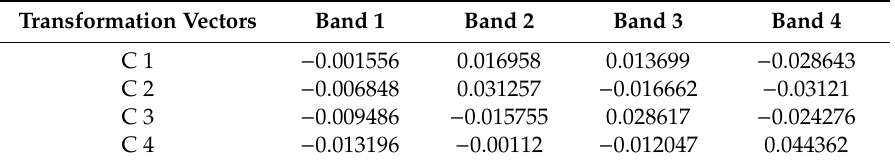
Table 7. Transformation vectors of MNF analysis on a spectral subset of the ASTER data for detecting the propylitic alteration zones in the study area.